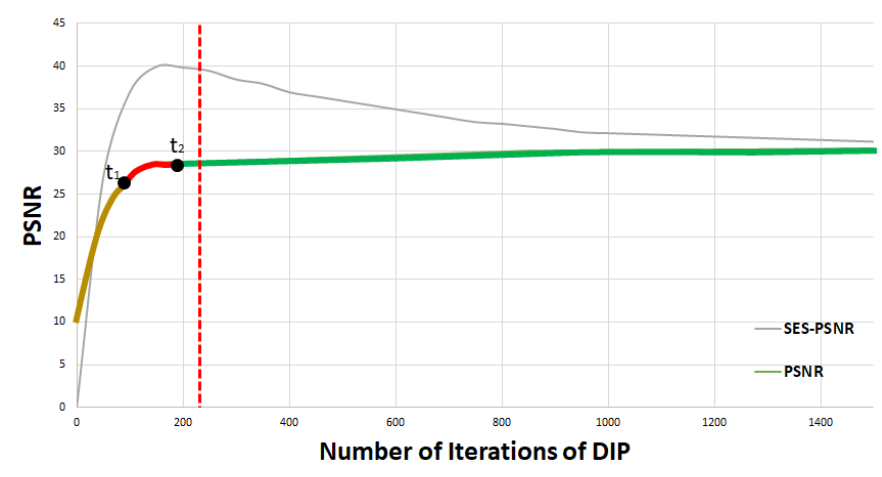
Figure 5. SES-PSNR and PSNR by DIP